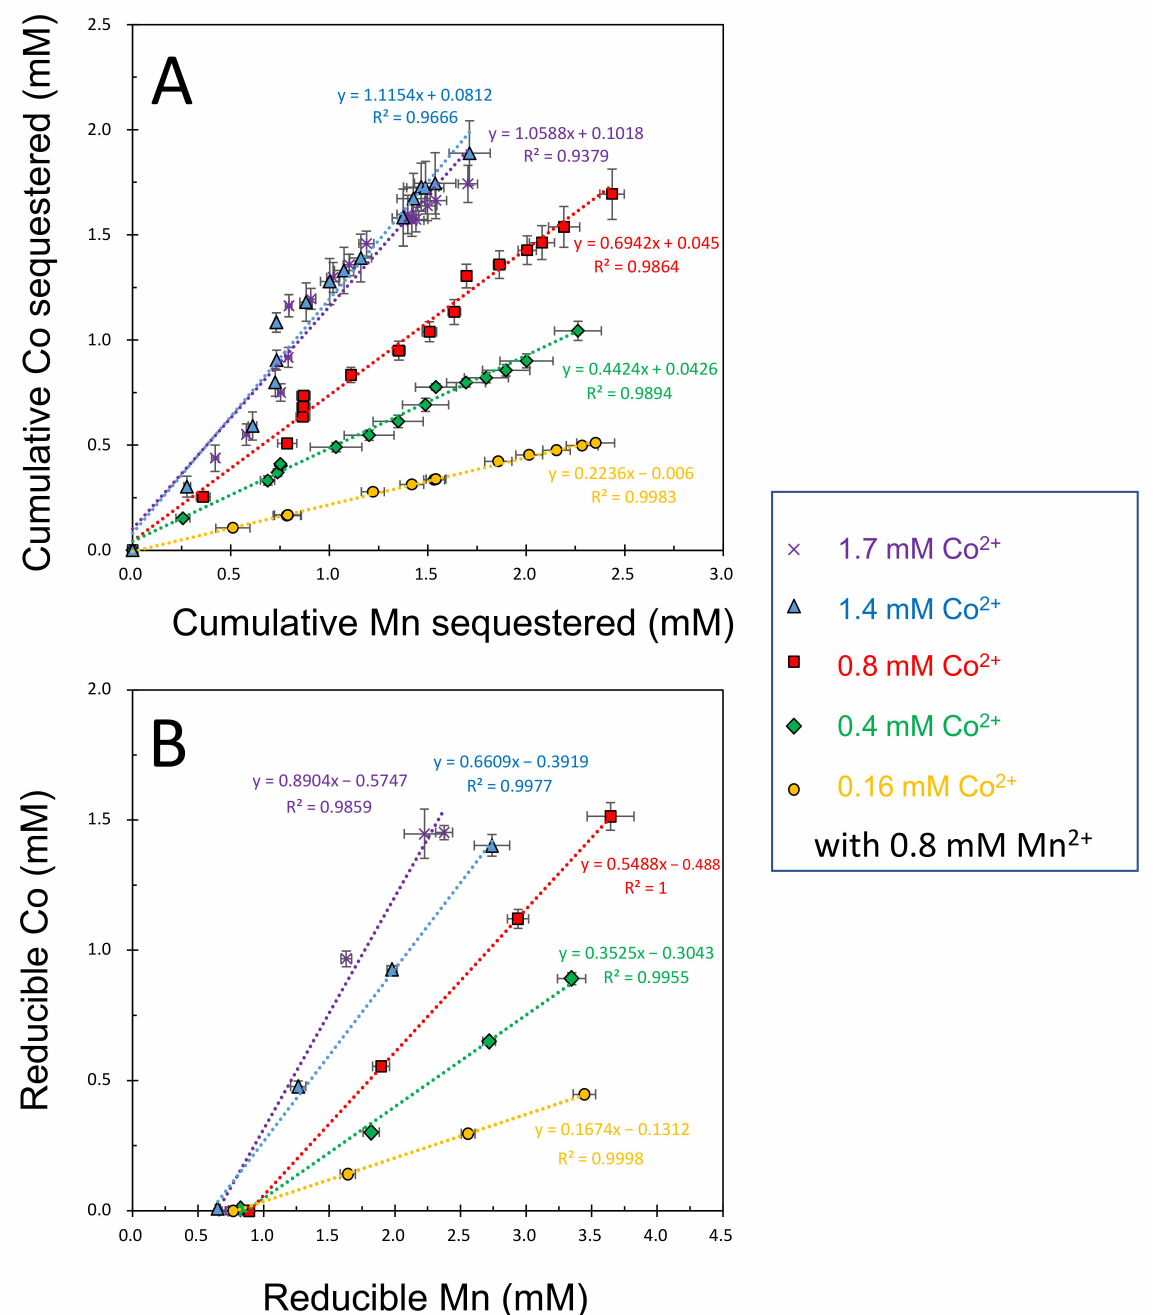
Figure 4. Relationships ( A ) between cumulative Co and Mn sequestrated and ( B ) between reducible Co and Mn in the solid phase throughout repeated treatment experiments of newly formed biogenic manganese oxides (1 mM as Mn) in Mn 2+ /Co 2+ binary solutions under aerobic conditions at pH 7.0 (100 mM HEPES buffer). Initial Co 2+ concentrations were 0.16, 0.4, 0.8, 1.4, and 1.7 mM with a constant exogenous Mn concentration of 0.8 mM. Bathing solutions were renewed every 24 h. Data are the mean ± standard deviation ( n = 3 or